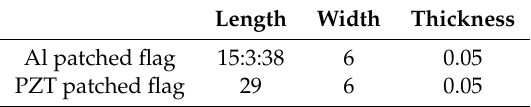
Figure 5. Overall circuit diagram for energy harvesting. Table 5. Dimensions of flag in experimental campaign (cm); these flags are represented in Figure